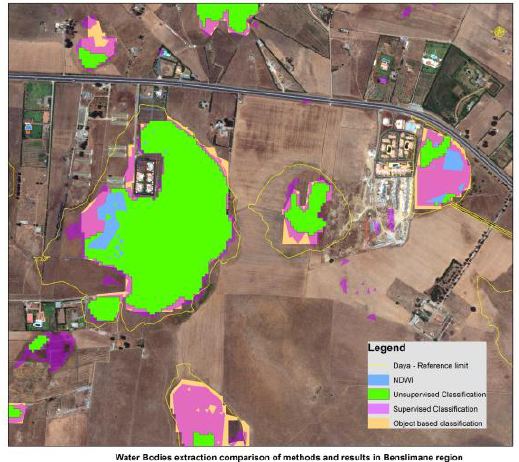
Figure 8. Comparison of the results of the classifications adopted in the study The comparison of the results with the limits of the dayas defined by the topographic surveys shows that the object- oriented classification makes it possible to extract the dayas better than the other classification approaches used. The figure above shows the limits obtained by the different classification approaches in comparison with the topographic survey. The disadvantage of the object-oriented method is that it can not extract dayas of small sizes. This remains relative to the parameterization of the algorithm and to the basic characteristics of the satellite images